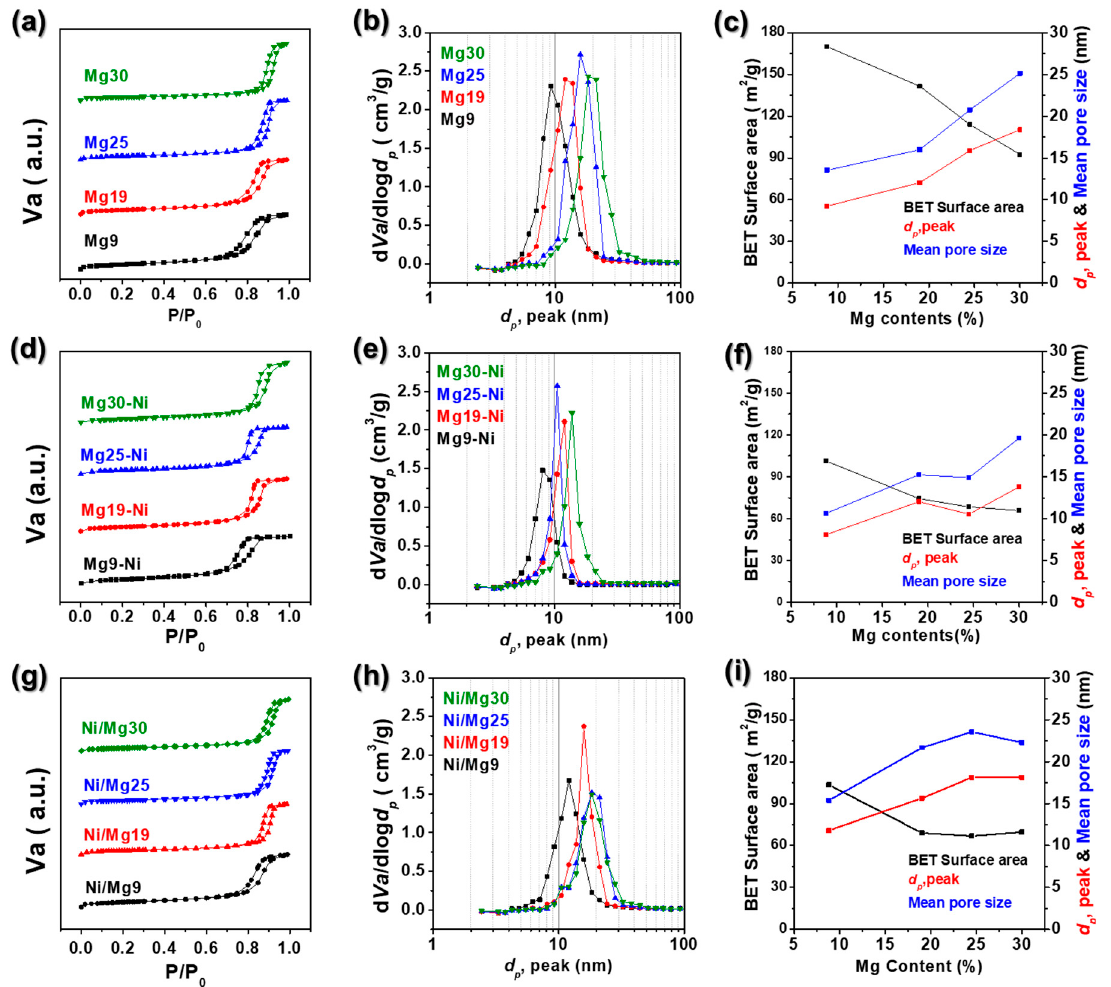
Figure 2. BET and BJH analysis of ( a – c ) Mg-aluminate support, ( d – f ) after Ni loading with calcination, and ( g – i ) after reduction: ( a , d , g ) N 2 adsorption-desorption isotherms, ( b , e , h ) BJH pore size distributions, and ( c , f , i ) plots of BET surface area, d p value, mean pore size versus Mg contents.